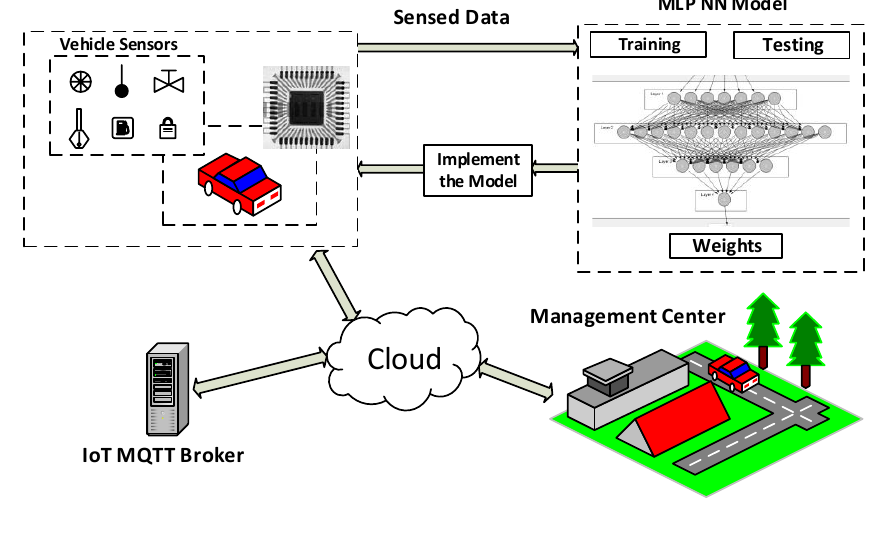
Figure 1. The proposed smart device